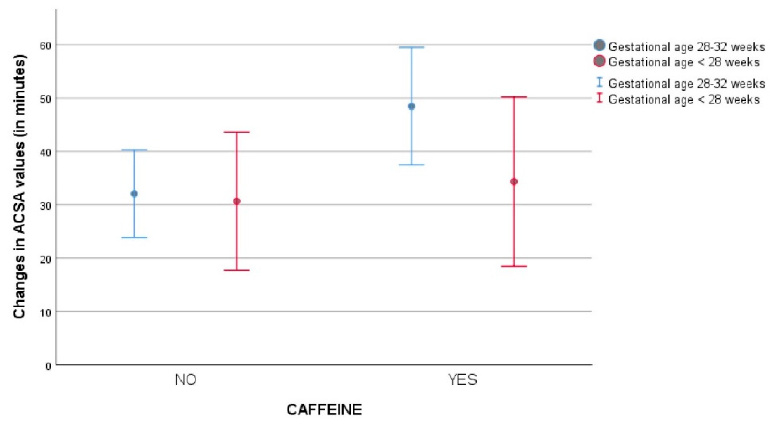
Figure 2. Distribution of Antral Cross Sectional Area (ACSA) values [mean—95% confidence intervals) in the study groups according to gestational age (<28 weeks vs. 28–32 weeks).